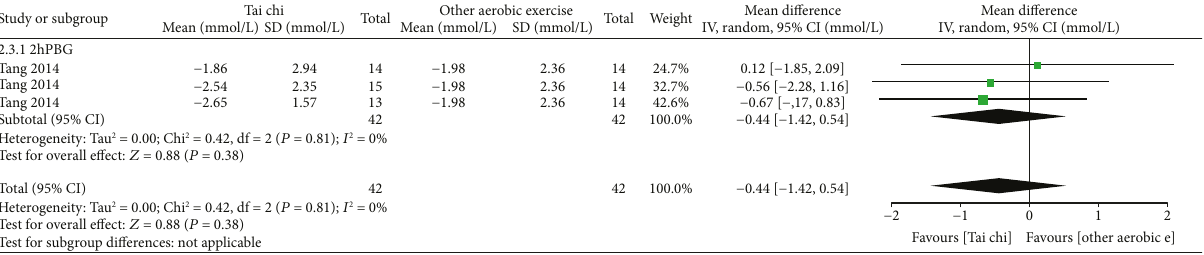
Figure 7: The meta-analysis for comparing 2hPBG between Tai chi and other aerobic exercises. CI: con fi dence interval; SD: standard